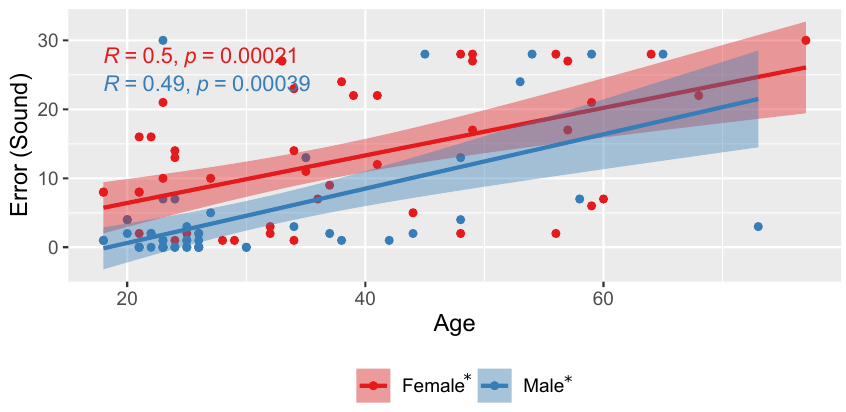
Figure 7. Error versus Age in Sound condition: correlation for males and females displayed using a scatter plot with regression lines and 95% confidence interval. Significant correlations are marked with